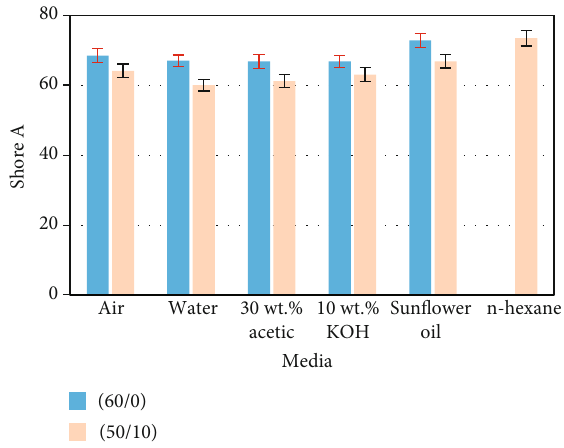
Figure 3: The shore A of PVC after 72 hours of soaking in